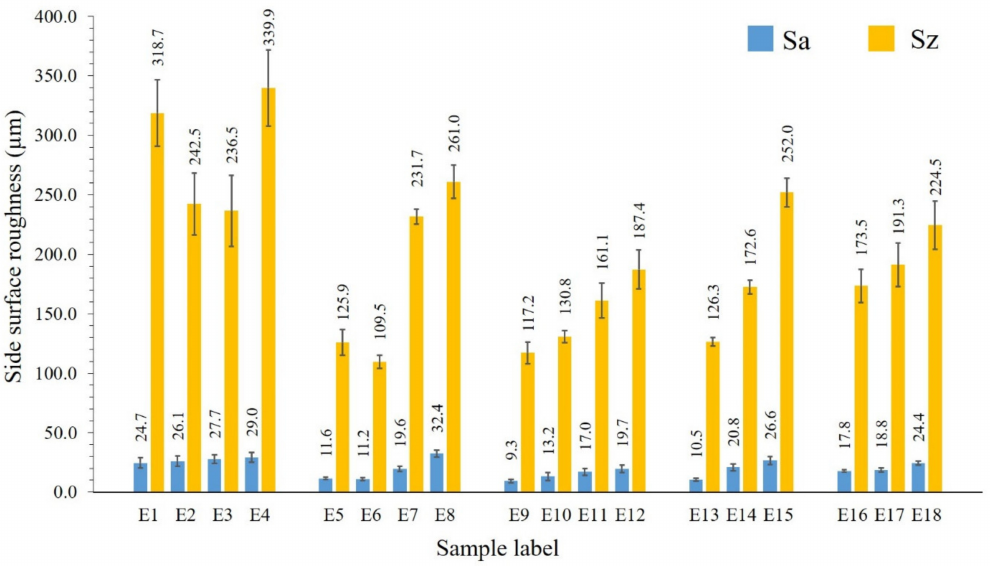
Figure 5. Side surface roughness results for samples